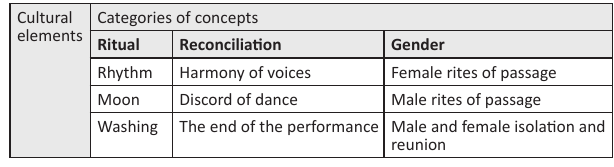
FIGURE 1: Ritual, reconciliation and gender in cultural